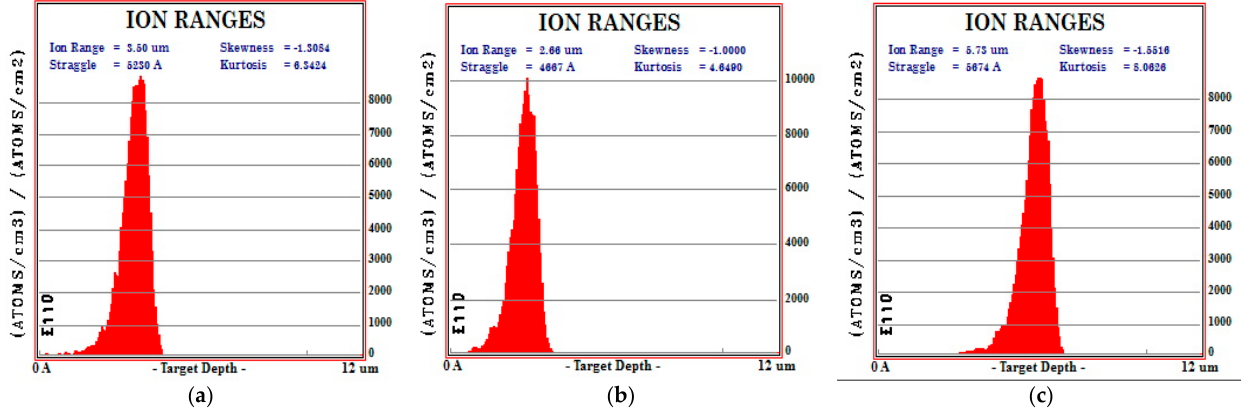
Figure 3. Ion ranges for: ( a ) Pd with energy 19 MeV; ( b ) Ru with energy 12 MeV; and ( c ) Rh with energy 45 MeV, in E110 Alloy. The maximum implantation depths for this FPs are: 5.5 µm for Pd, 2.66 µm for Ru, and 5.7 µm for Rh respectively.